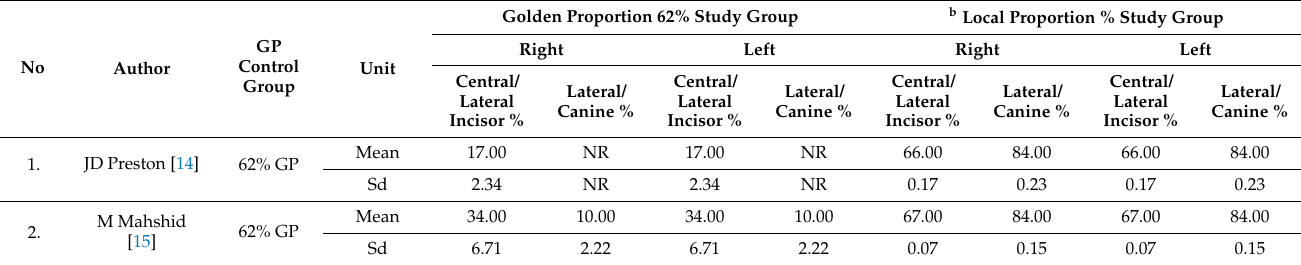
Table 1. Characteristics of golden proportion among included studies ( n =